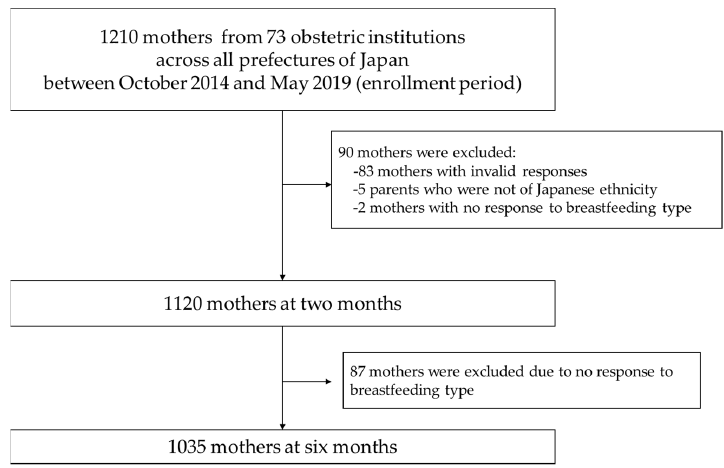
Figure 1. Study enrollment flowchart.